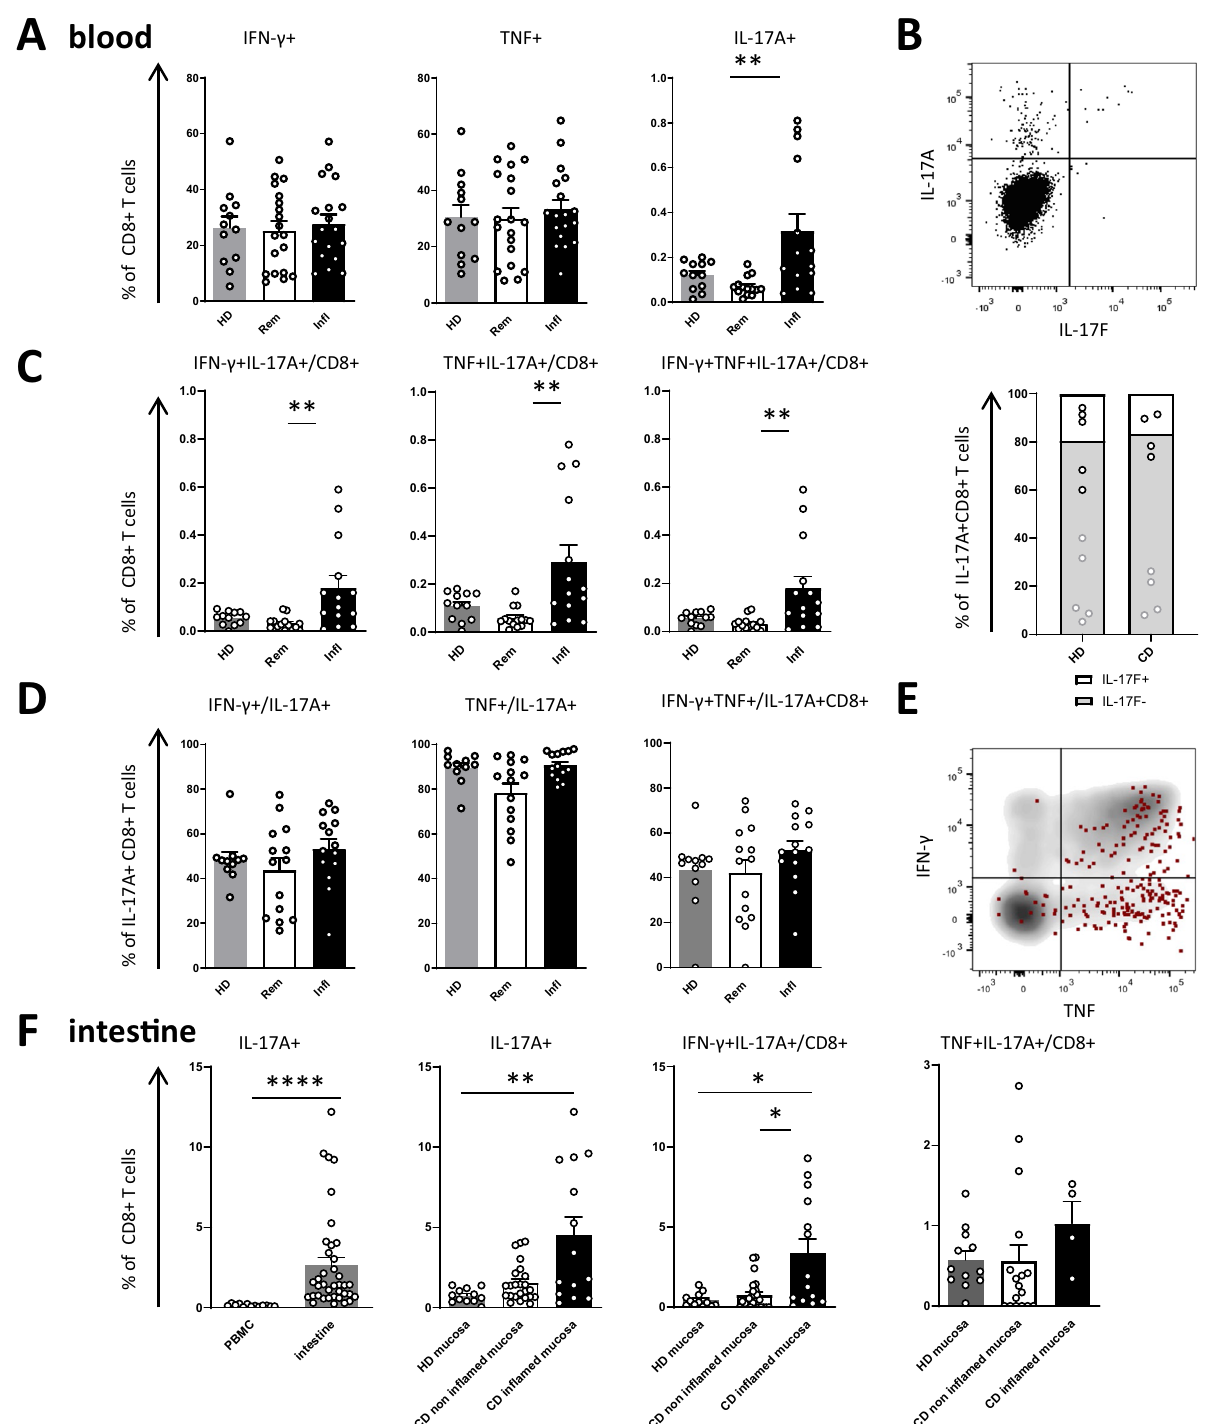
Fig. 1 IL-17 production by CD8 + T cells is increased in active CD. A Production and co-production ( C ) of IFN- γ , TNF and IL-17 by CD8 + T cells isolated from the peripheral blood was compared between healthy donors (HD, n = 12) and CD patients in remission (Rem, n = 19) or with active disease (In fl , n = 18). B Representative fl ow cytometry plot depicting IL-17A and IL-17F production of CD8 + T cells isolated from the peripheral blood of a CD patient with active disease and bar graph depicting IL-17F coproduction of IL-17A producing CD8 + T cells isolated from the blood of HD ( n = 5) and CD ( n = 4). D Analysis of IFN- γ and TNF co-production by Tc17 cells (HD, n = 11; Rem, n = 14; In fl , n = 14). E Overlay density plot depicts IFN- γ and TNF production by IL-17 producing (red dots) CD8 + T cells from the peripheral blood of a representative CD patient with active disease. F Comparison of IL-17 production in peripheral blood and intestinal mucosa of CD patients ( n = 38). Production of IL-17 and co-production of IFN- γ , IL-17 or TNF by CD8 + T cells in the intestinal mucosa was analyzed based on in fl ammation. Healthy donors (HD, n = 12), CD patients: non-in fl amed ( n = 24) and in fl amed ( n = 14) intestinal mucosa. Data in A, C, D, F are presented as mean + / − SEM. Statistical tests used were two-sided. **** p < 0.0001, *** p < 0.001, ** p < 0.01, * p <